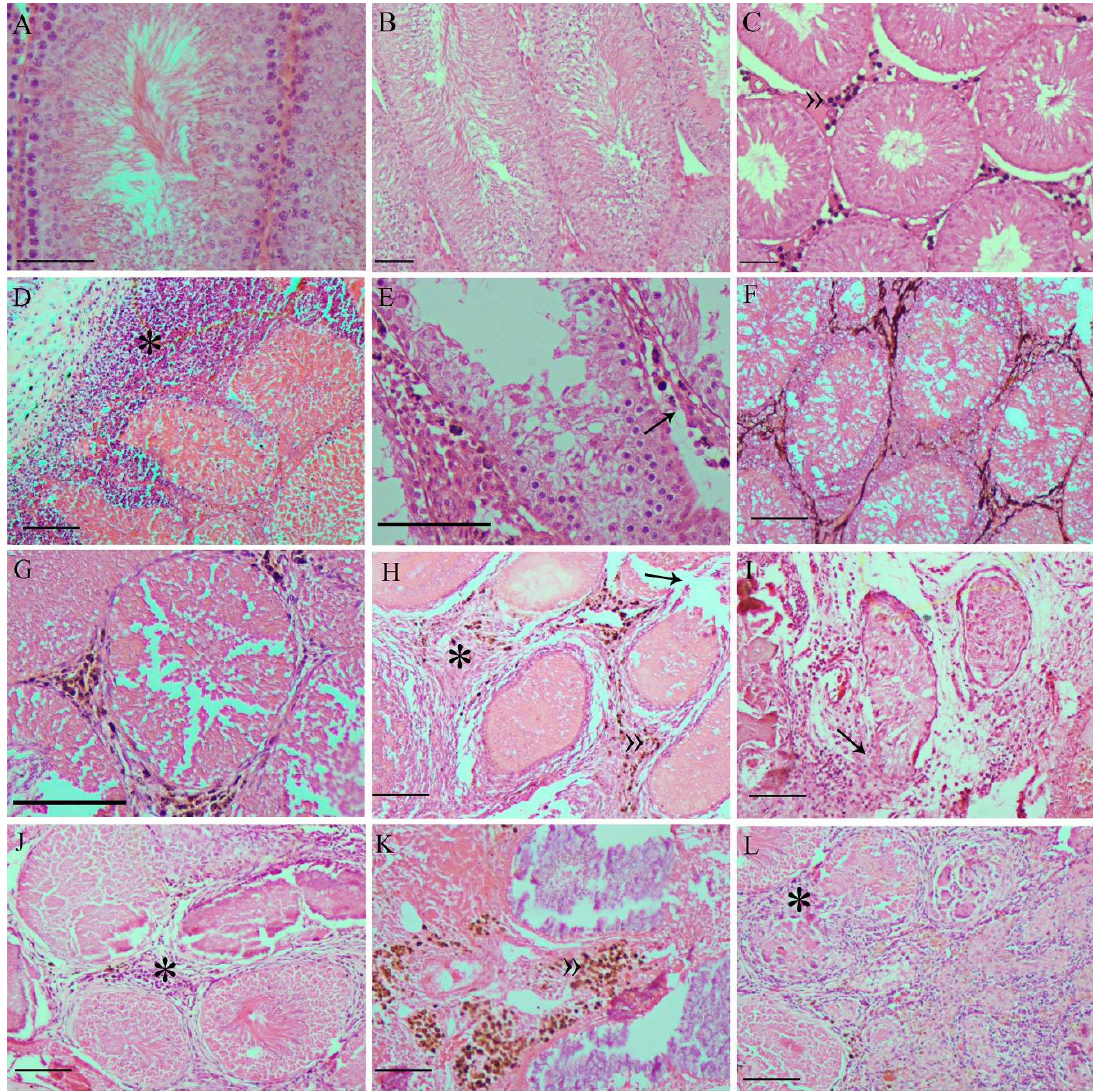
Figure 6. Representative photomicrographs of testicles from the: Saline ( A ), AC ( B ), and MF ( C ) groups, presenting normal seminiferous tubules and all germline cell types. In the MNH-D7 group ( D – F ), the seminiferous tubules presented damage to the germinal epithelium and rupture of the basement membrane was observed ( D ), in addition to blood leaking into the tubular lumen and inflammatory infiltrate (*) in the interstitial tissue ( E ). It was possible to identify nanoparticle agglomerates in the interstitium ( F ). In the MNH-D28 group ( G – I ), seminiferous tubules showed coagulative necrosis ( G ), the interstitial connective tissue was thickened (H), and the typical tubular structure was lost ( I ). Nanoparticle agglomerates are still visible in the interstitium ( G , H ). In the MNH-D56 group ( J – L ), seminiferous tubules lost definition ( J , K ) and began to be replaced by connective tissue ( L ), the nanoparticle agglomerates are still visible (K). »: nanoparticle agglomerates; black arrows: seminiferous tubule basement membrane rupture; *: inflammatory infiltrate. Bars = 10 µm.